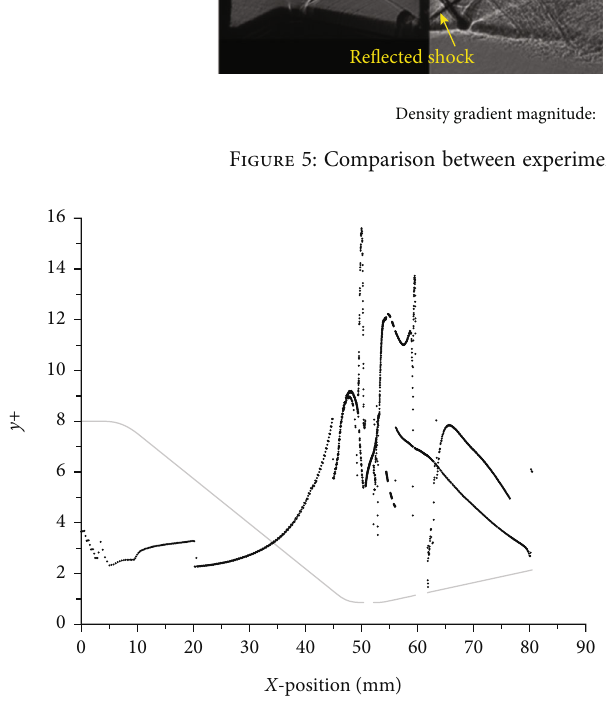
Figure 6: y + for 3D